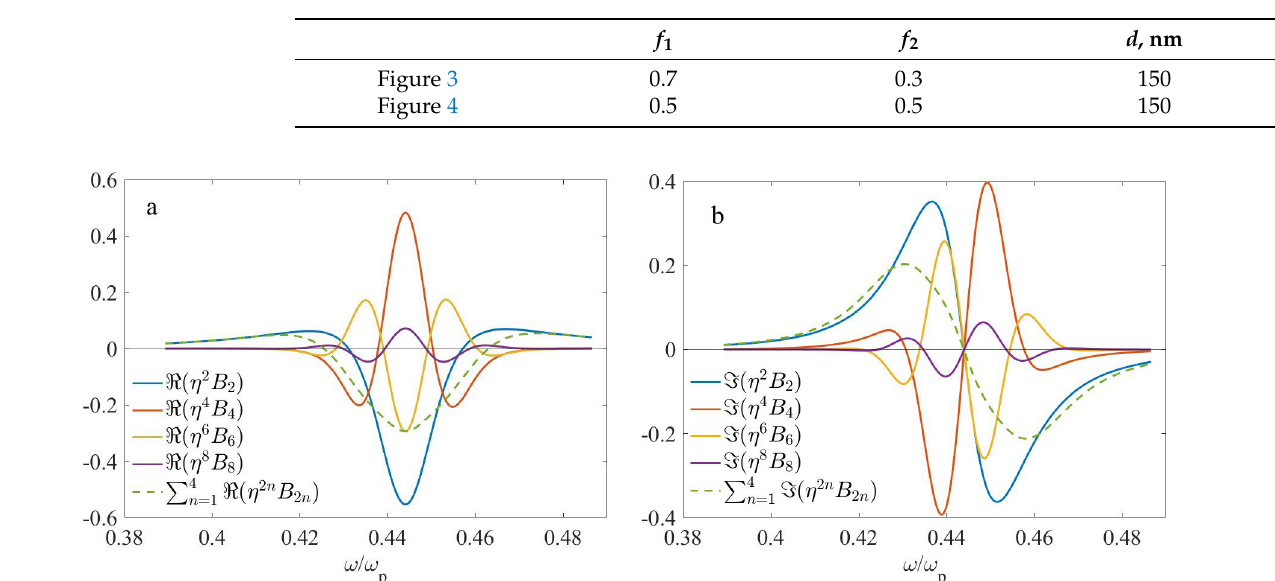
Figure 3. The frequency dependencies of the nonlocal corrections to the effective permittivity at